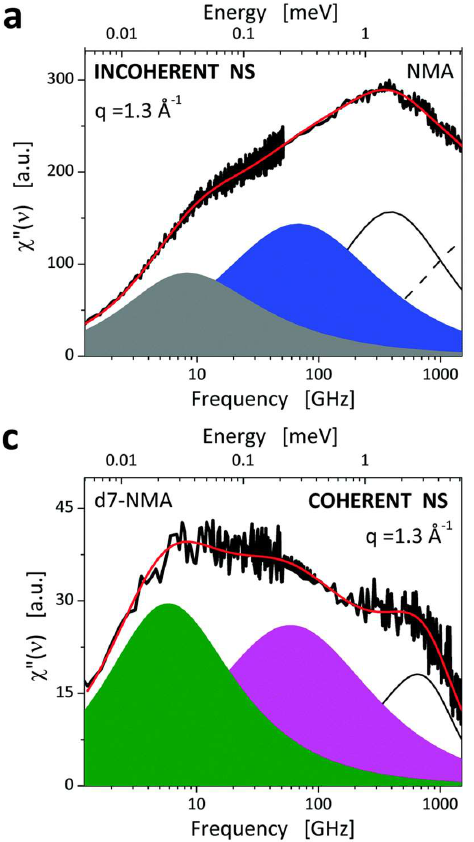
Fig. 8 . Fitting of inelastic neutron scattering spectra from n-methylacetamide. Top: incoherent spectra, four components. Bottom: coherent spectra, three components. Reprinted with permission from [26]. Copyright 2017 The Royal Society of